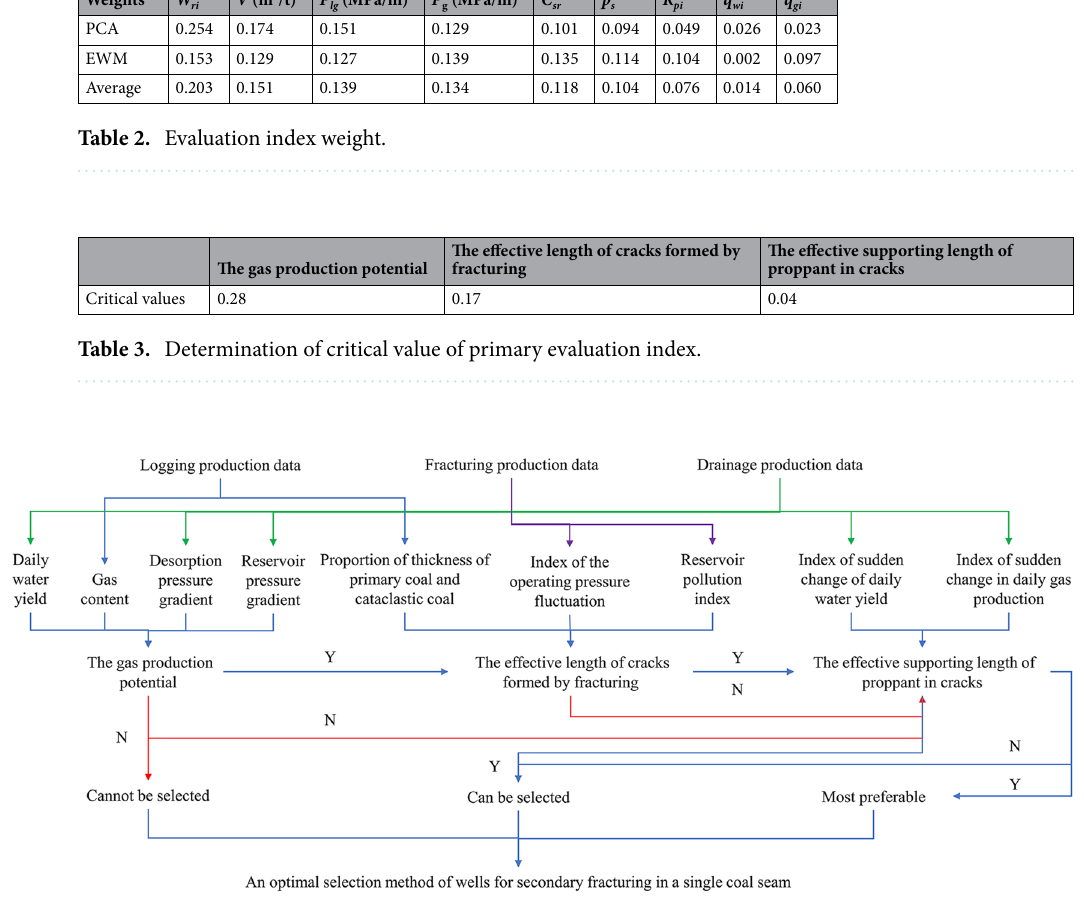
Figure 5. An optimal selection method of wells for secondary fracturing in a single coal